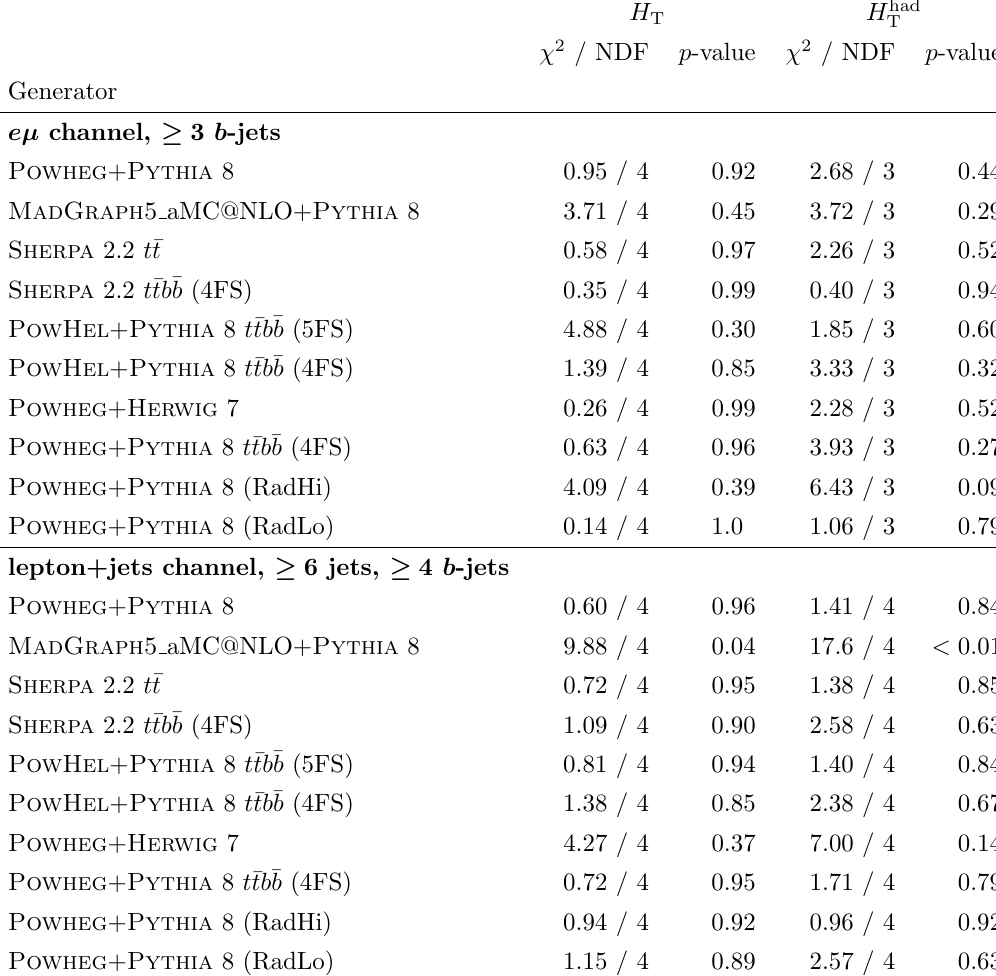
Table 8. Values of (cid:31) 2 per degree of freedom and p -values between the unfolded normalised cross- sections and the various predictions for the H T and H had channels. The number of degrees of freedom is equal to the number of bins in the measured distribution minus